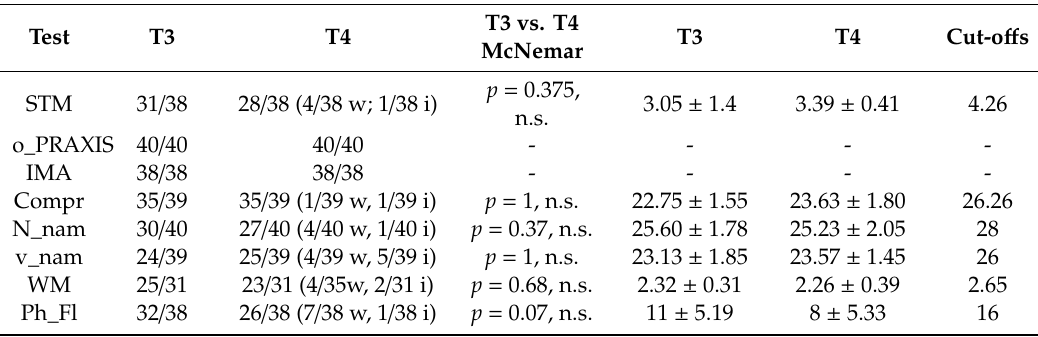
Table 2. Number of patients with recurrent glioma whose results were within the normal range at T3 and T4 (pre and post-recurrence surgery, respectively), and the results of the McNemar test (T3 vs. T4). We stratified patients who worsened (w, those within the normal range at T3 who were below the normal range at T4), and improved (i, those below the normal range at T3 who were within the normal range at T4). The mean and standard deviation of patients who scored below the normal range (and the cut-off) are shown in grey. To date, the level of performance of those patients was only slightly below the cut-offs.